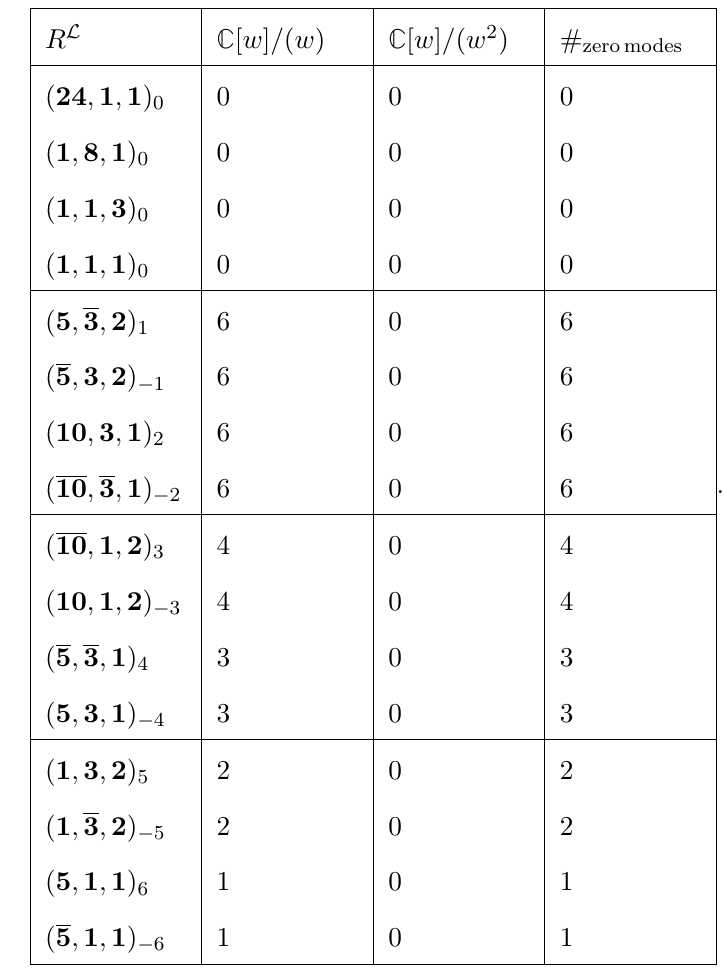
Table 4 . Five-dimensional modes for E 8 length six simple